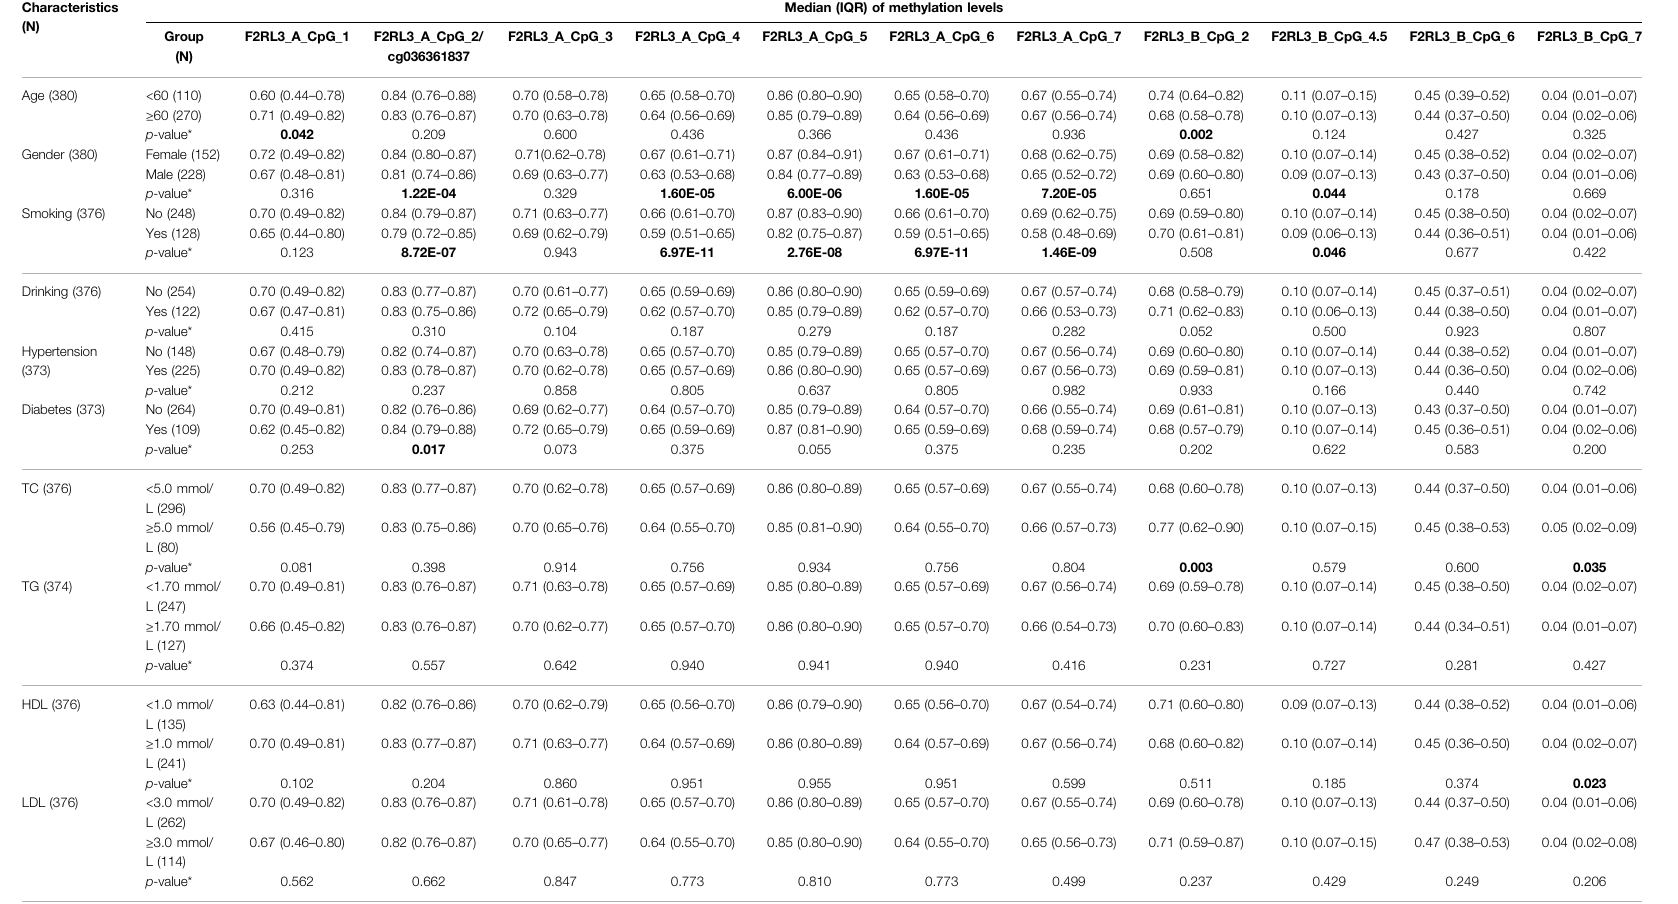
TABLE 4 | The association between F2RL3 methylation and CHD-related characteristics in the study subjects. Characteristics